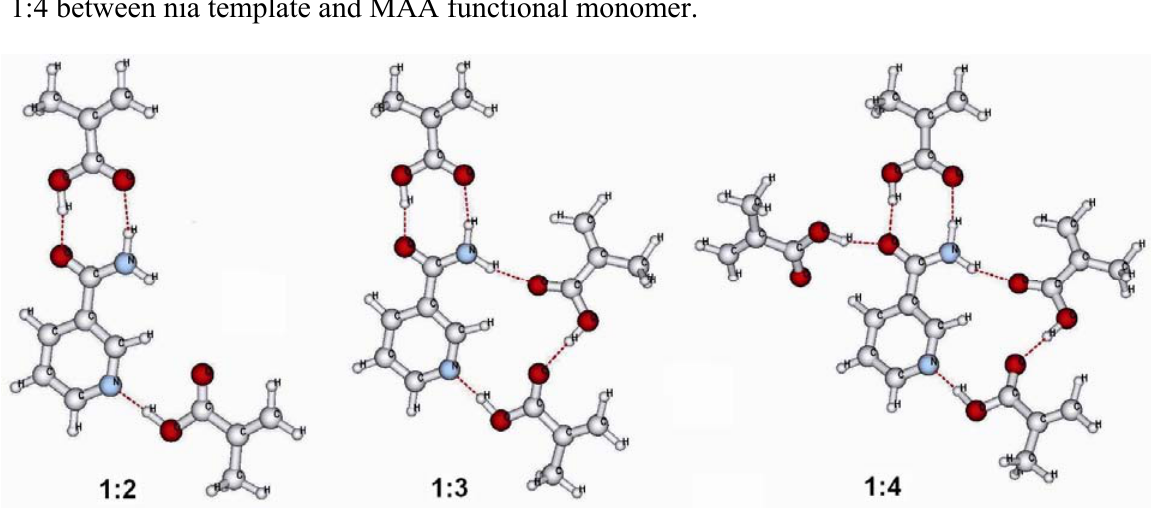
Figure 3. The most stable prepolymerization-complex structures for a ratio of 1:2, 1:3 and 1:4 between nia template and MAA functional